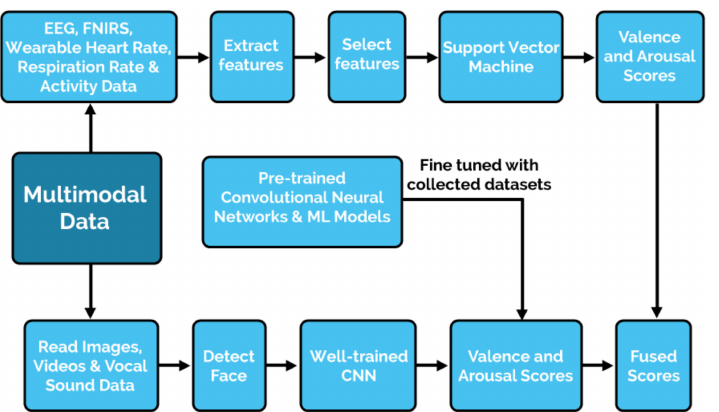
Figure 2. Multimodal affective state recognition data analysis workflow framework of the per-animal quantified approach. EEG—electroencephalogram; FNIRS—functional near-infrared spectroscopy; ML—machine learning; CNN—convolutional neural networks.